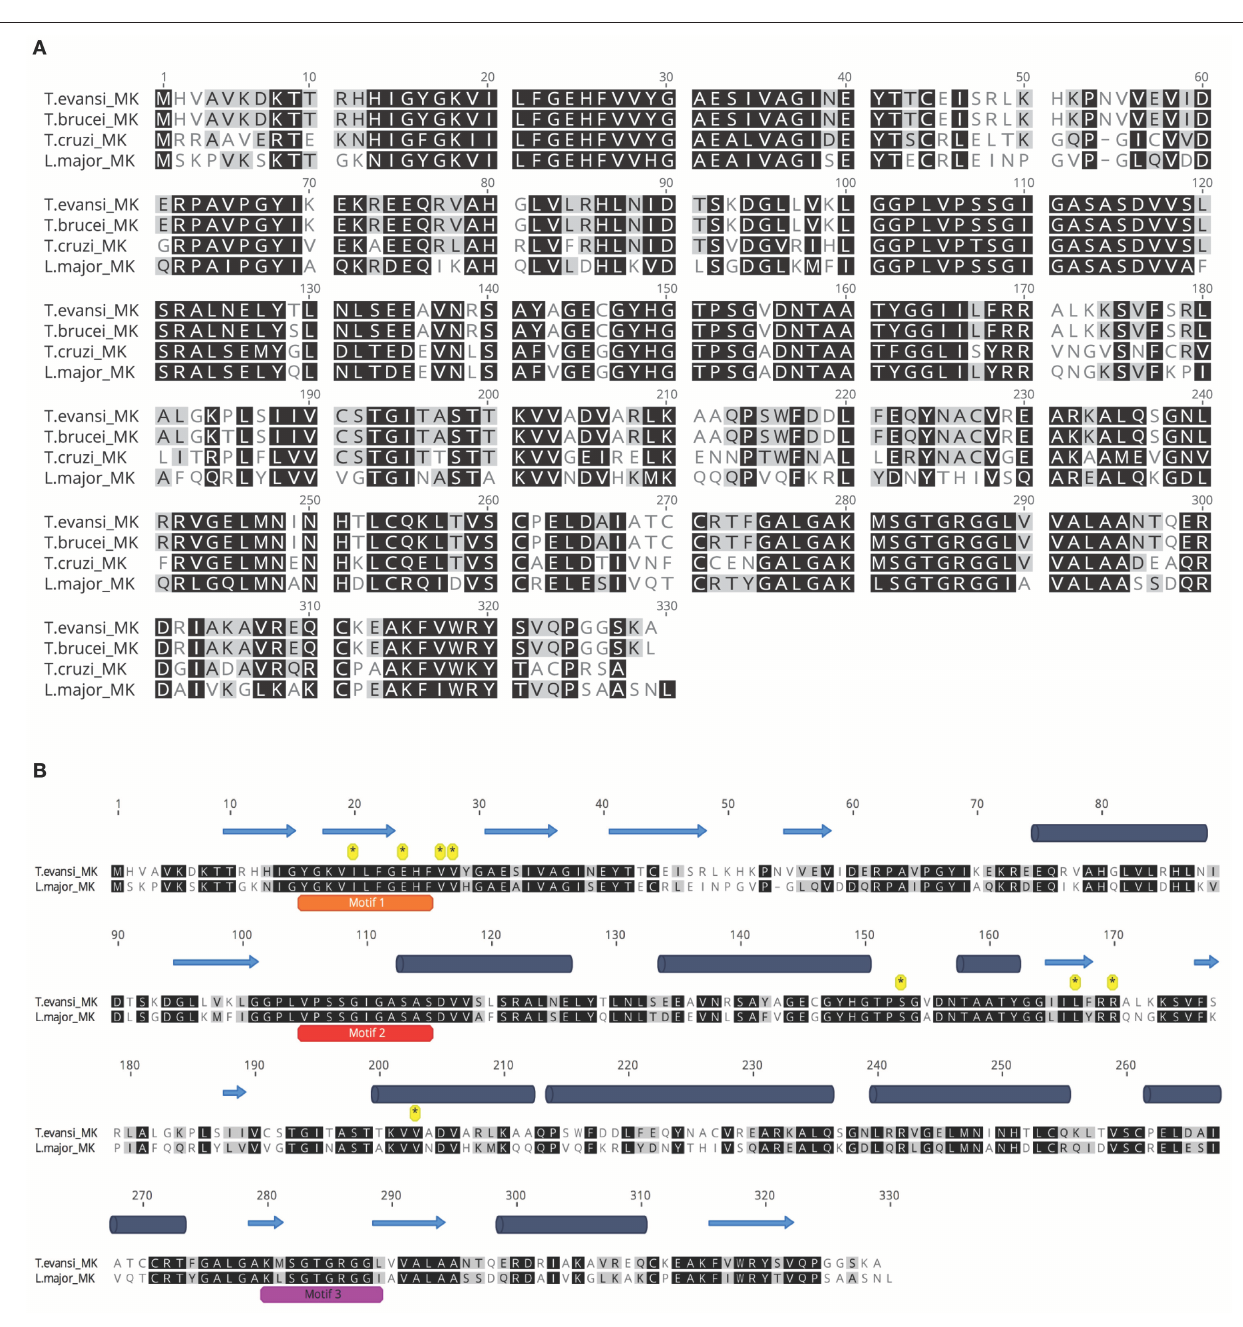
Frontiers in Cellular and Infection Microbiology |